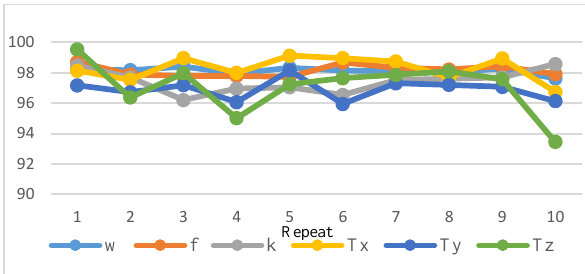
Figure 15. Relative accuracy for each registration parameter